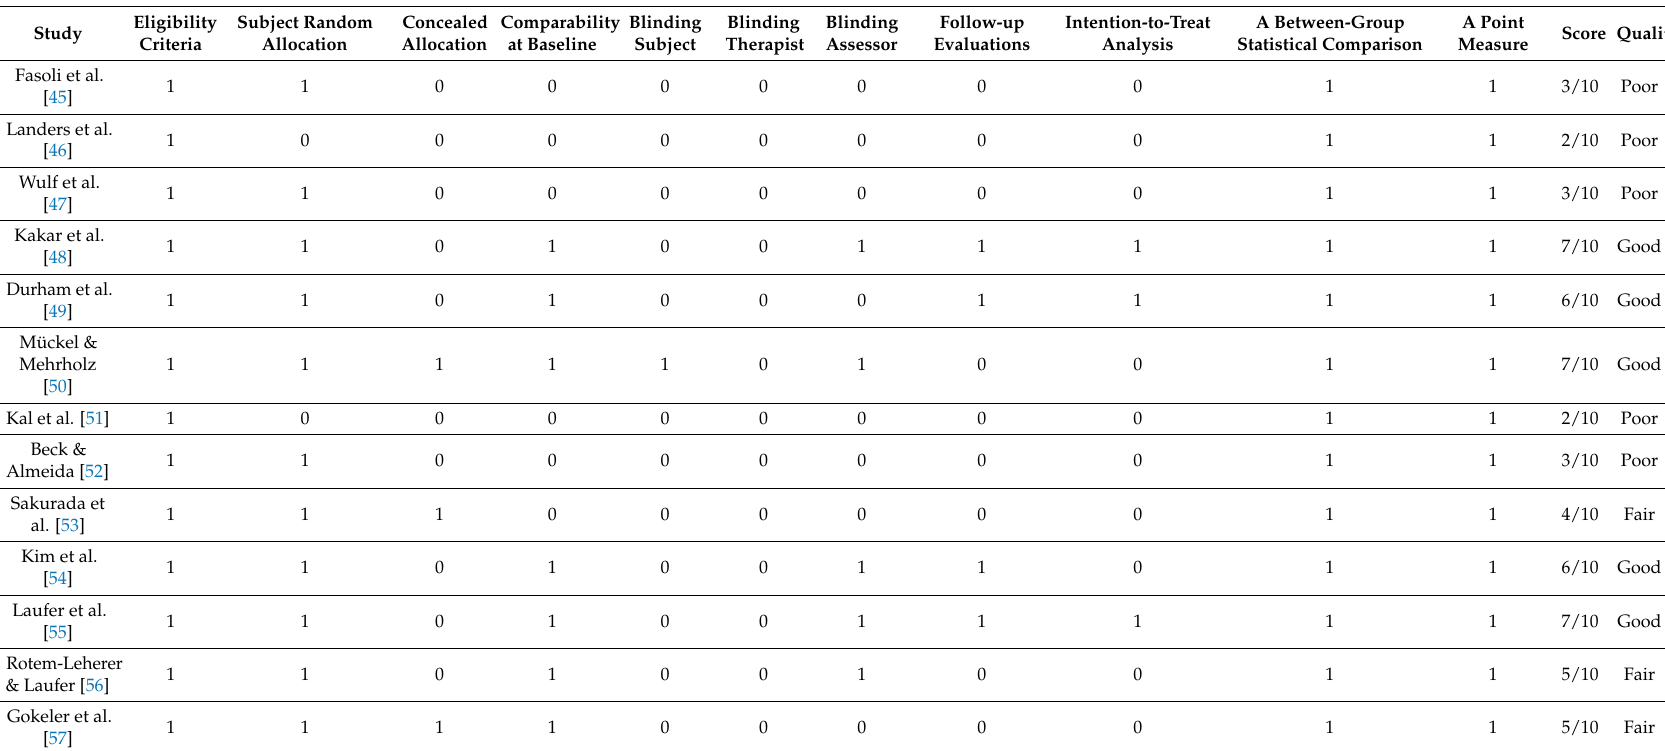
Table 1. Critical appraisal of